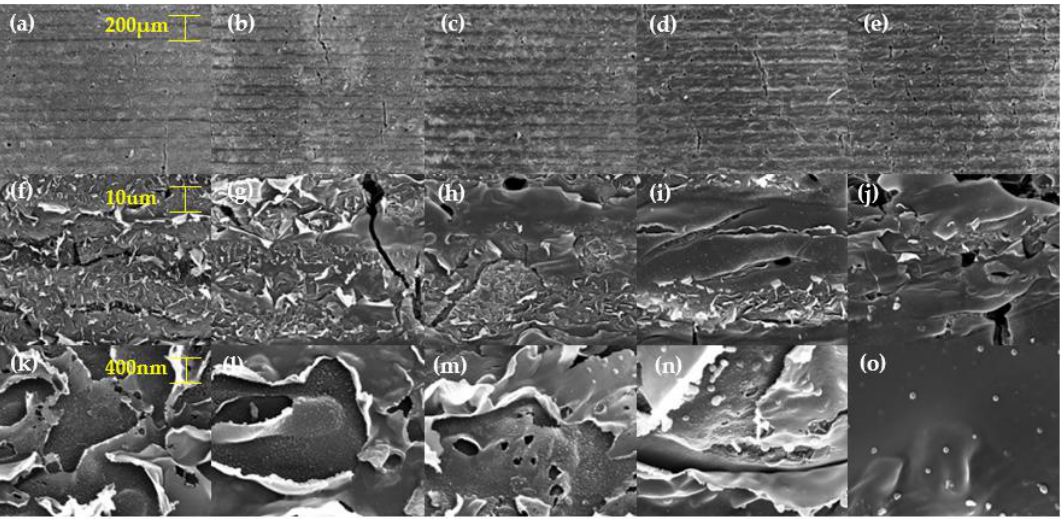
Figure 5. FE-SEM images of pulse-overlapped patterns fabricated ( a , f , k ) at 100 mm/s, ( b , g , l ) at 80 mm/s, ( c , h , m ) at 60 mm/s, ( d , i , n ) at 40 mm/s and ( e , j , o ) at 20 mm/s.